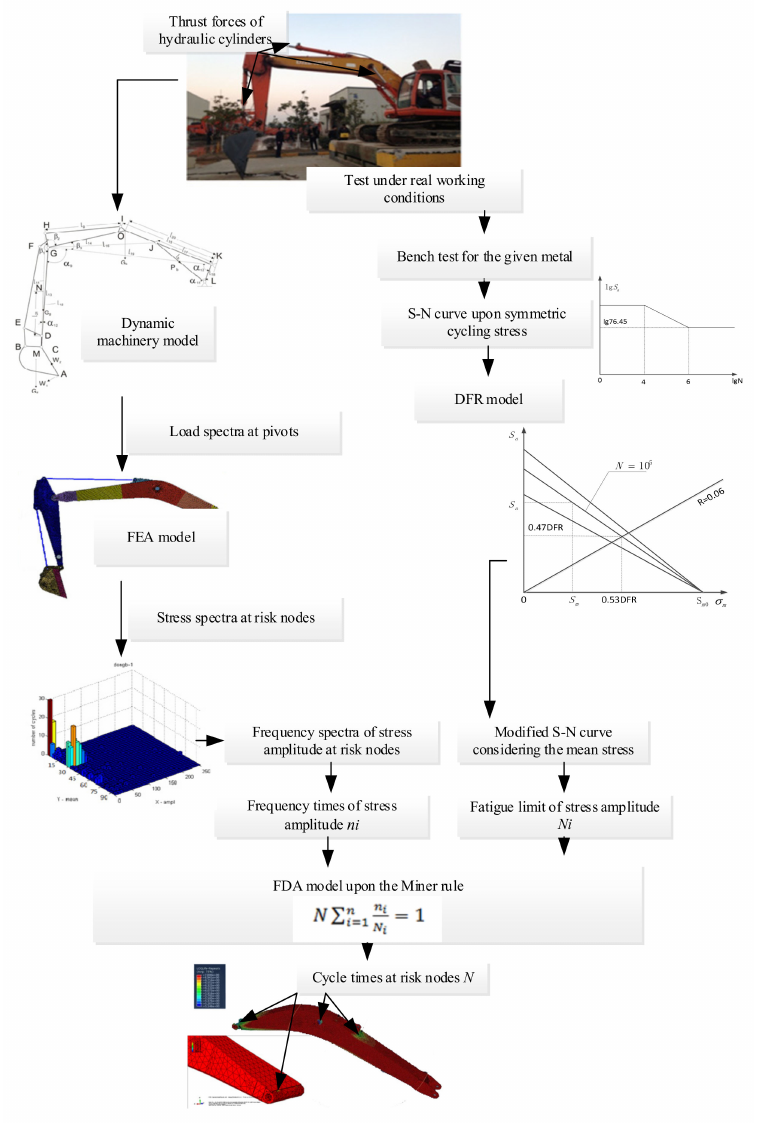
Figure 1. The technical framework and critical fatigue models for the excavator